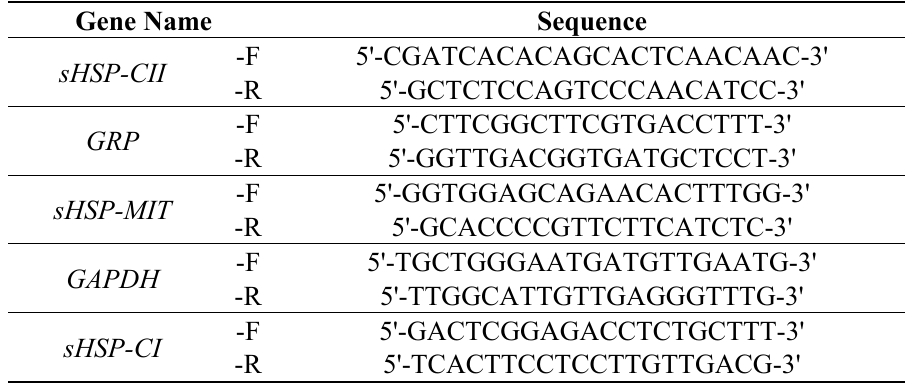
Table 2. Real-time quantitative PCR primer